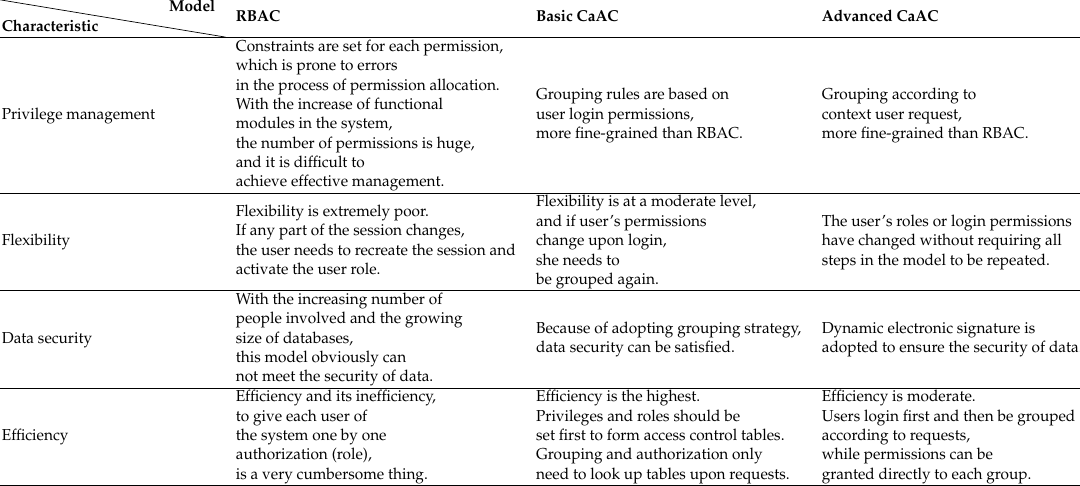
Table 1. A comparison between the CaAC model and the traditional